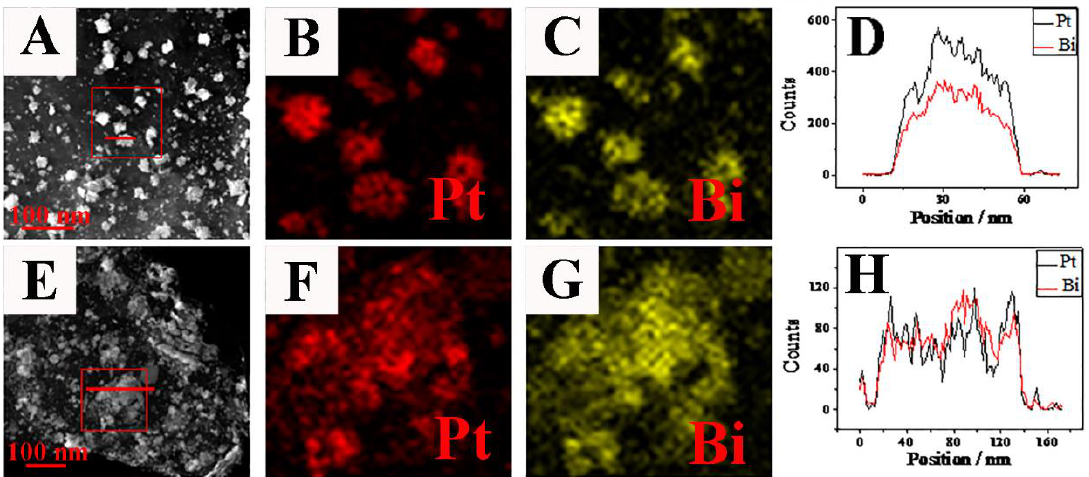
Figure 3. The high-angle annular dark-field scanning transmission electron microscopy (HAADF-STEM) images: Pt-Bi (Bi 2 O 3 )/GNs (PVP) ( A ), Pt-Bi (Bi 2 O 3 )/GNs ( E ); Elemental mapping images: Pt ( B ) and Bi ( C ) for Pt-Bi (Bi 2 O 3 )/GNs (PVP), Pt ( F ) and Bi ( G ) for Pt-Bi (Bi 2 O 3 )/GNs; The distribution of Pt and Bi ( D ) and Pt and Bi ( H ) atoms along the corresponding cross-sectional line shown in ( A , E ) respectively.